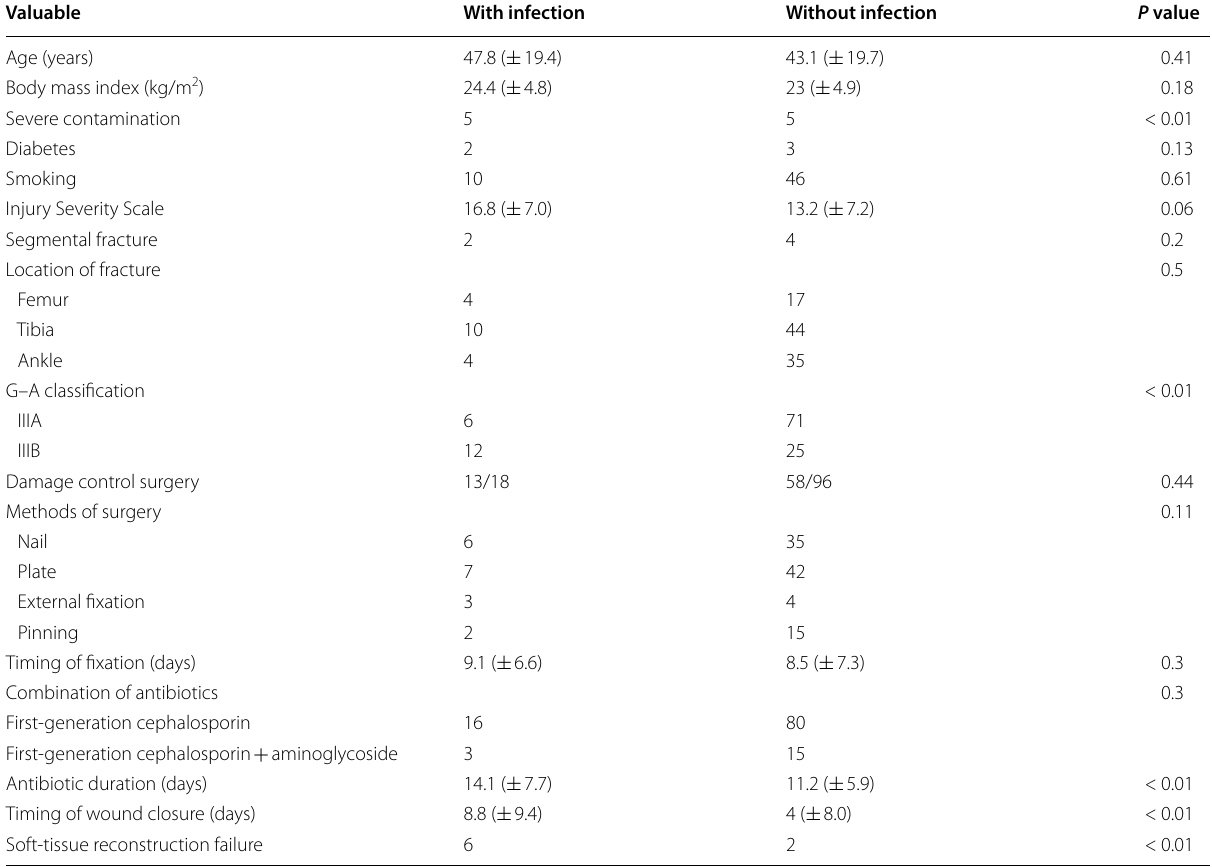
Table 3 Comparison of fractures with and without infection Valuable With